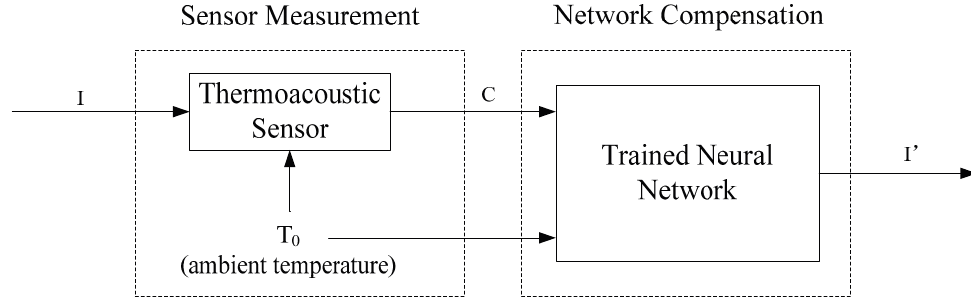
Figure 7. Model of the thermoacoustic sensor compensation using a neural network. The neural network algorithm is implemented using a